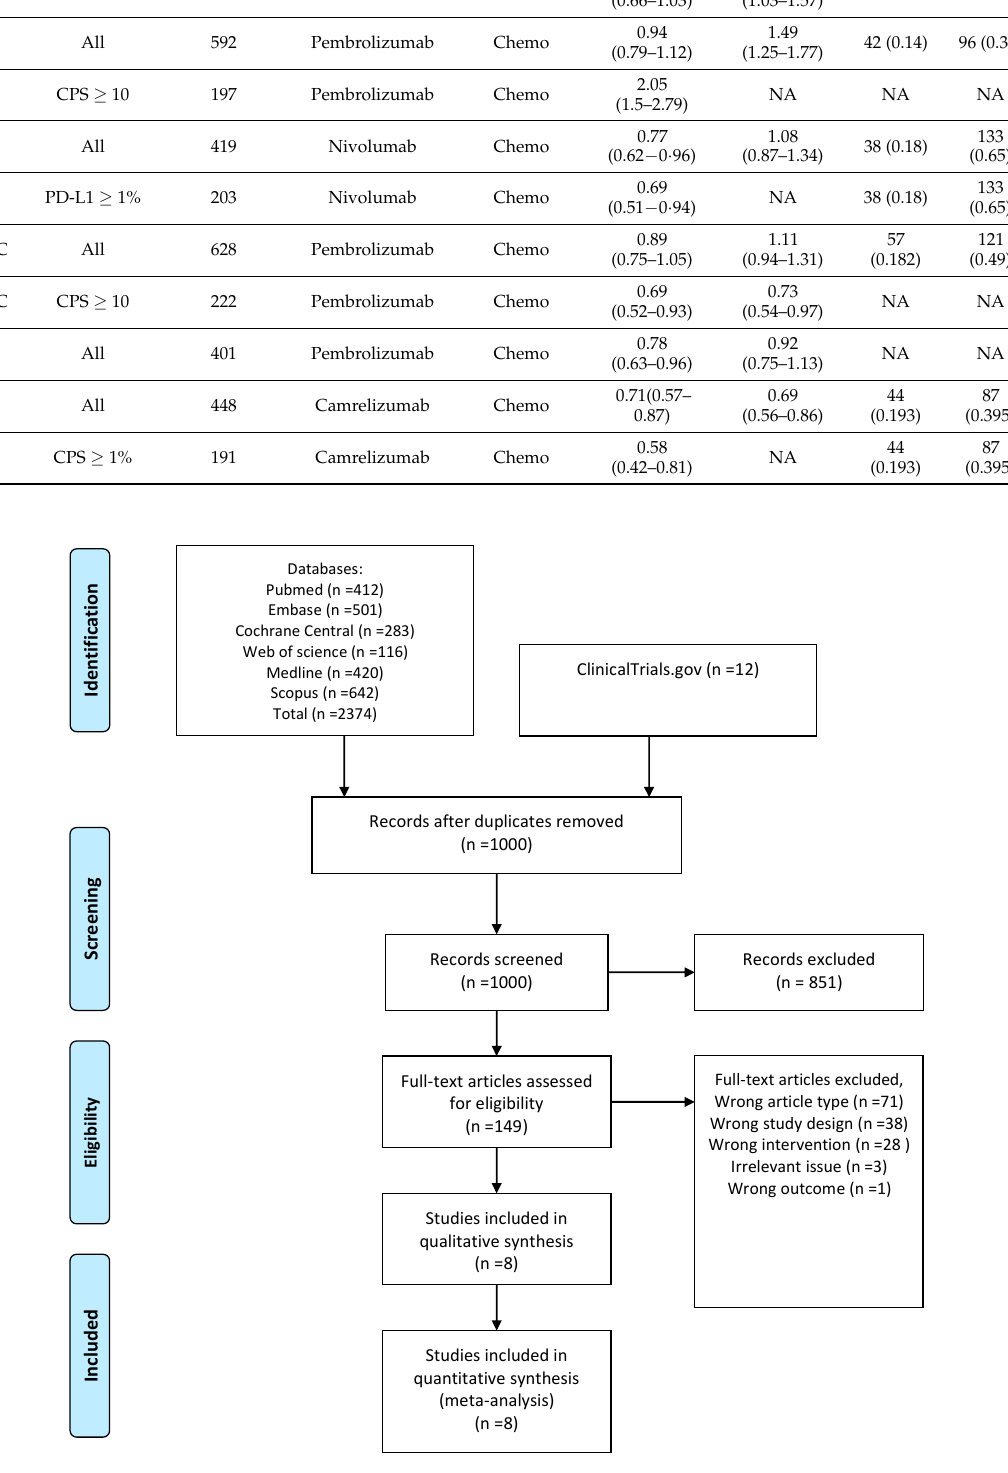
Figure 1. Flowchart of the study selection process. Figure A1. Flowchart of the study selection Table A2. Outcomes according to subgroups in the first-line setting.